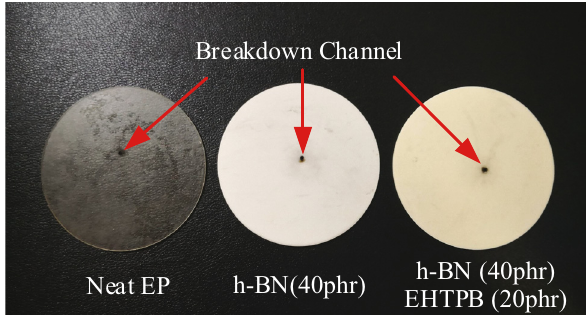
Figure 11: Samples and their breakdown channels after breakdown strength test.